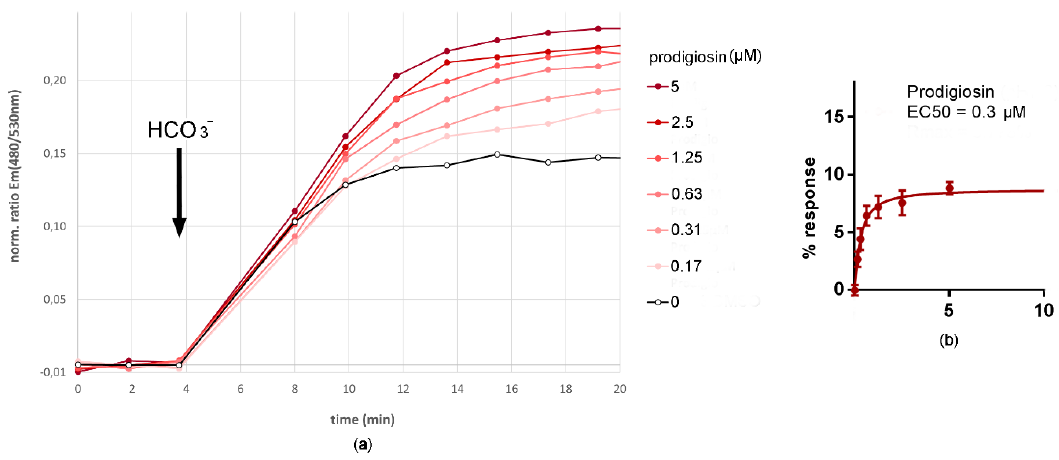
Figure 11. Bicarbonate efflux assay - bicarbonate transport activity of prodigiosin. The bicarbonate biosensor cell line measures bicarbonate efflux facilitated by the naturally occurring anionophore prodigiosin in a concentration-dependent manner in a range from 0 to 10 µM prodigiosin. Upon withdrawal of bicarbonate from the assay buffer, an intracellular decrease in bicarbonate concentration caused an intracellular decrease in cAMP. ( a ) This resulted in a decrease in the fluorescence emission ratio Em(480 nm/530 nm) when exited at 430 nm in the bicarbonate sensor cell expressing both, the sensory unit sAC tr and the reporting unit CEPAC of the bicarbonate sensory cellular test system. ( b ) A 4-parameter sigmoid concentration-response curve was generated from the percentages of changes in fluorescence emission ratio relative to the control without prodigiosin 9 min after bicarbonate withdrawal. From this concentration-response curve, the EC50 value for prodigiosin